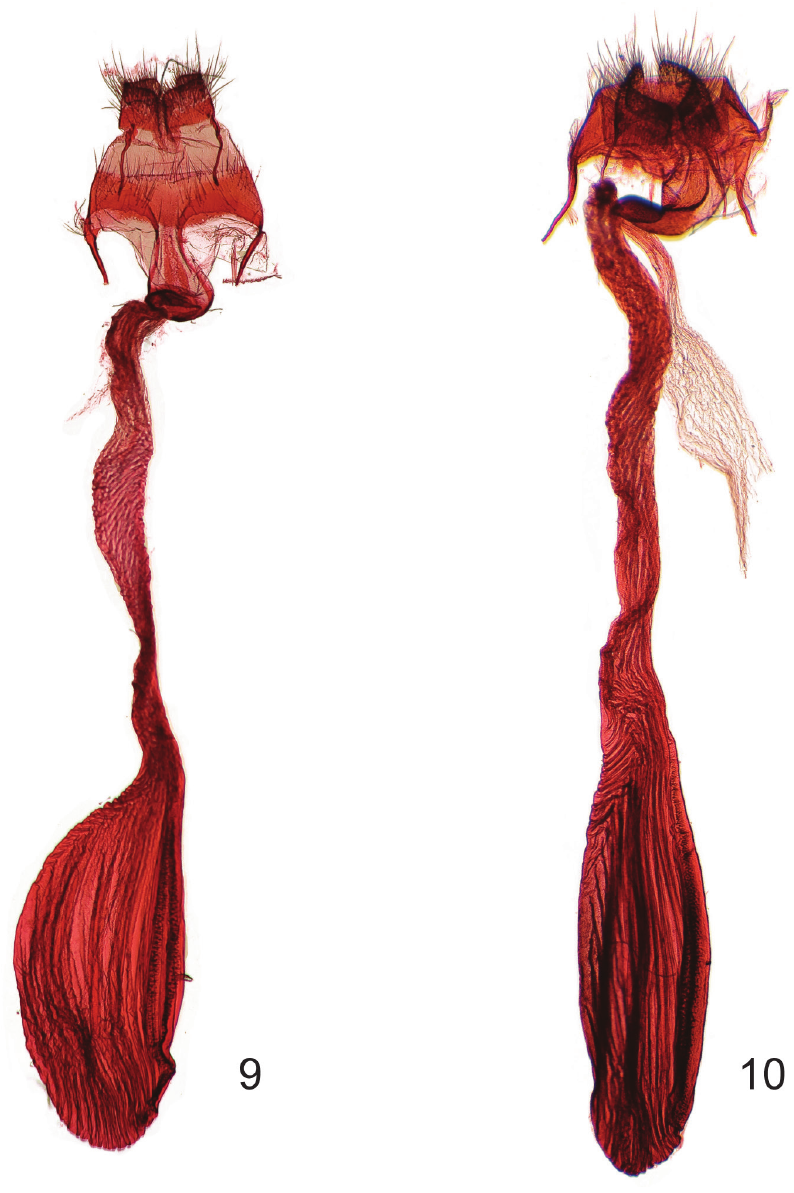
tium bursae bulb-shaped, narrow at exit of eighth tergite, then bulbous basally; ductus bursae short, sclerotized, and quadrate at exit from ostium bursae, remainder elongate, membranous slightly widens to elongate corpus bursae; signum an elongate, crenulate ribbon almost length of corpus